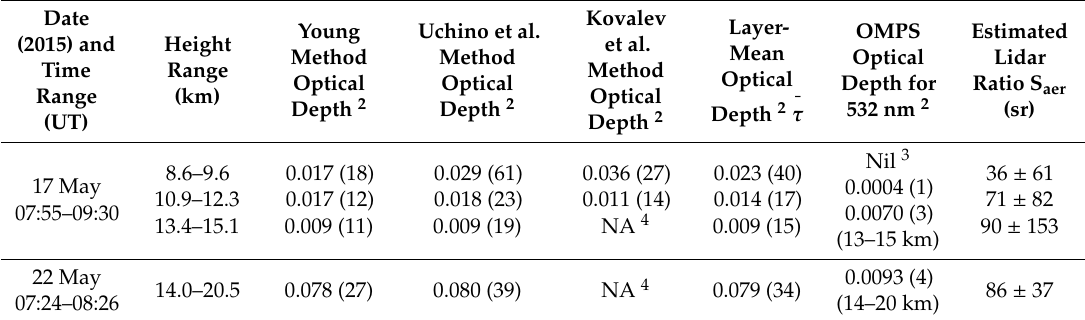
Table 4. Evaluations of layer-mean optical depth and lidar ratio at 532 nm from Kingston measurements at 100 m vertical resolution.